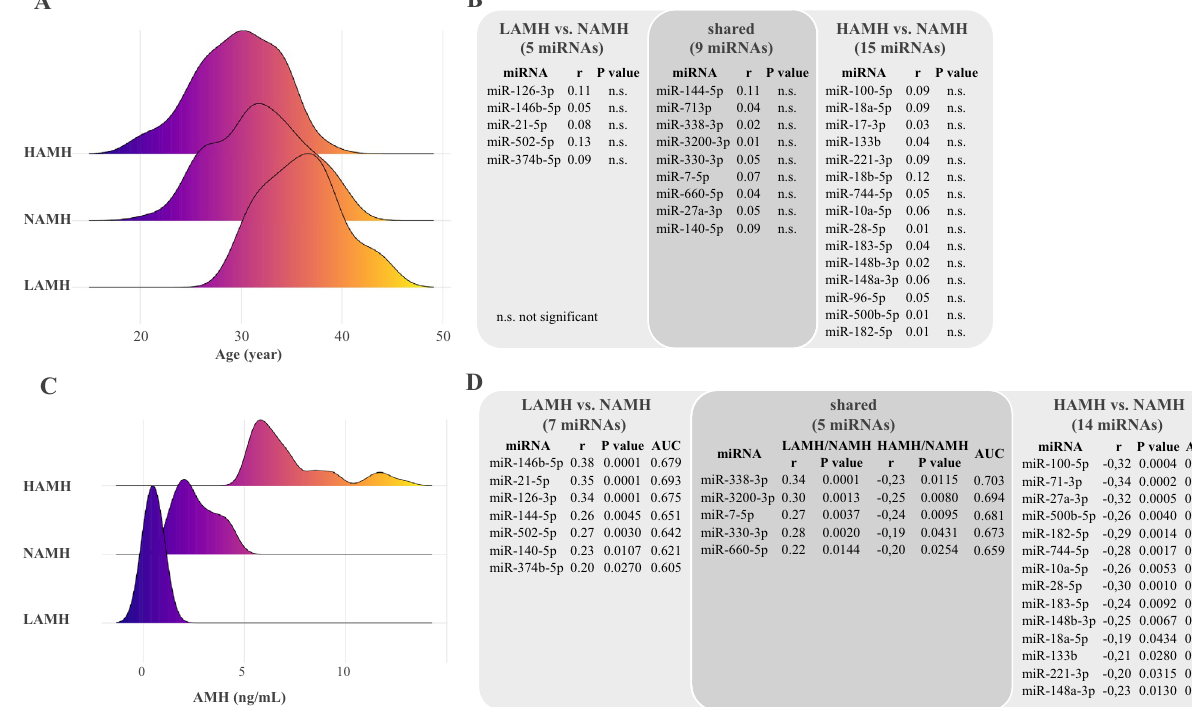
Figure 2. ( A ) Differences in the miRNA abundance level based on age, ( B ) correlation analysis of the differentially abundant miRNAs, which were validated exclusively in LAMH versus NAMH and HAMH versus NAMH with age, ( C ) Differences in the miRNA abundance level based on AMH (ng/ml), ( D ) Correlation analysis of the differentially abundant miRNAs, which were validated exclusively in LAMH versus NAMH and HAMH versus NAMH with AMH. Spearman’s correlation; r, correlation coefficient; statistically significant if P value < 0.05. LAMH low anti-Müllerian hormone, HAMH high anti-Müllerian hormone, NAMH normal anti- Müllerian hormone, AMH anti-Müllerian